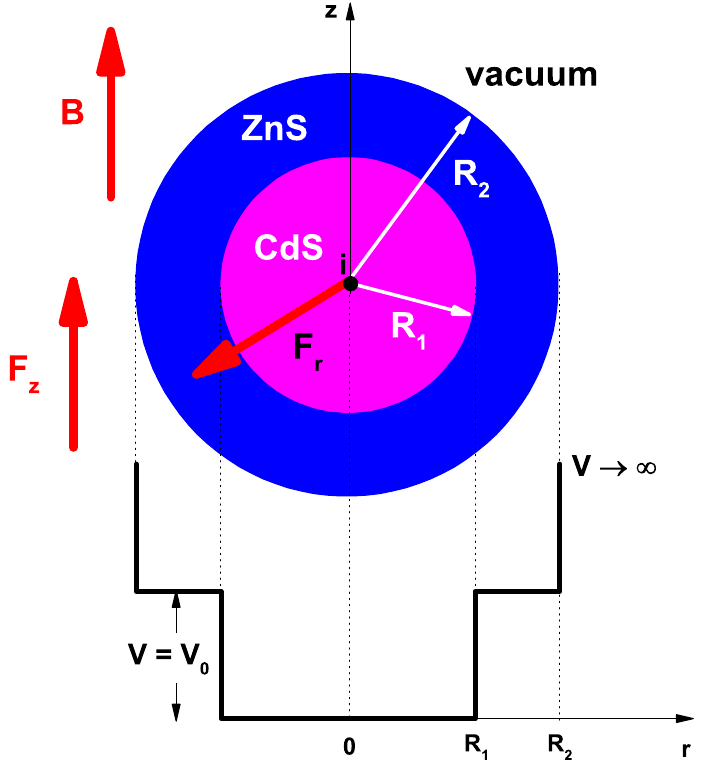
Figure 1. (color online) Pictorial view of the CdS/ZnS spherical QD studied in this work. The QD size, the z -directed applied EF and MF ( F z and B ), and the central EF ( F r ) are indicated, together with the r -dependent confinement